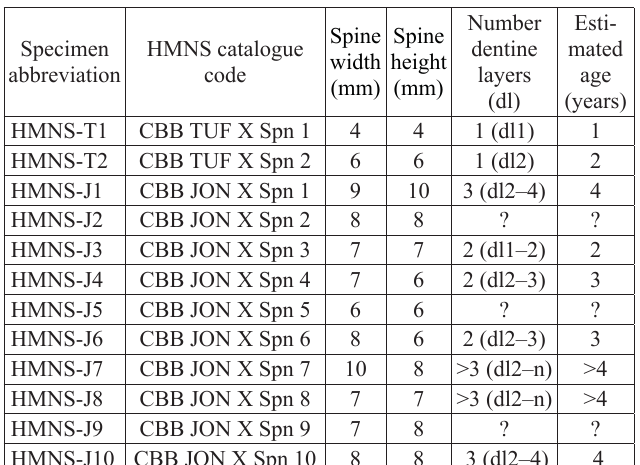
Table 1. Orthacanthus platypternus dorsal spines sampled. Measure- ments are given for the most proximal point available and are round- ed to the nearest millimeter. The measured cross-sections are from non-denticulated regions, except for specimen HMNS-J3, cut at the level of the denticulated region. With the exception of HMNS-T1 and HMNS-J3, dentine layer 2 is assumed to be the older layer recorded in the cross-sections of the spines because dentine layer 1, represent- ing the juvenile stage SP1, becomes restricted to the distal part of the Orthacanthus spines during growth (cf. Soler-Gijón 1999) and it is already absent in the non-denticulated region of the small spine HMNS-T2 (see longitudinal section in Fig. 4). Abbreviation: dl, den- tine layer of centrifugally growing